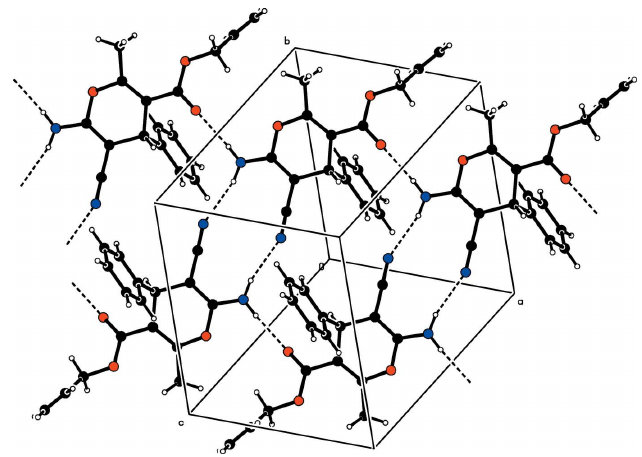
Figure 2 The packing of the title compound (major disorder component only). N—